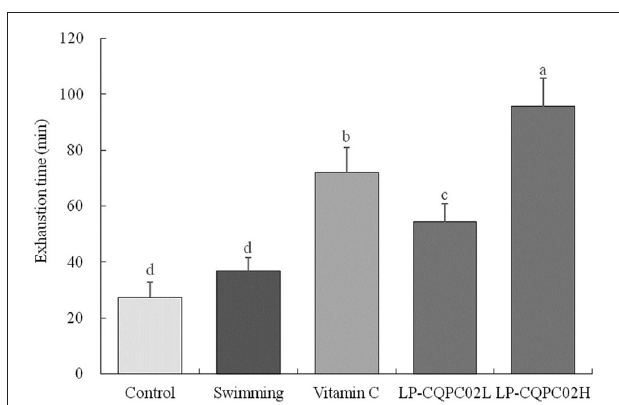
FIGURE 1 | Swimming exhaustion time of mouse in each group. “ ± ” for standard deviation. a − d After the Tukey’s honestly significantly different test analysis, there is significant difference between the two groups with different superscript ( P <